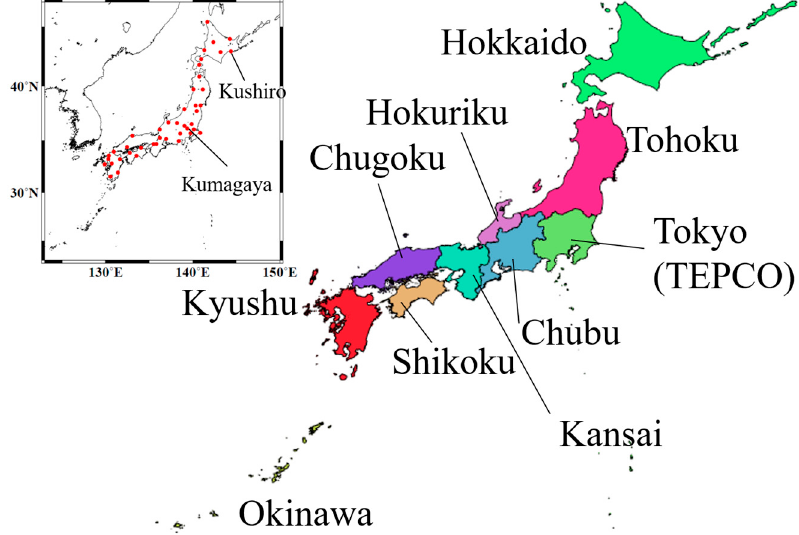
Figure 1. Map of Japanese islands and 10 electric power grids. Red squares indicate the locations of Japan Meteorological Agency’s (JMA’s) global horizontal irradiance (GHI) observation stations including the Kushiro and Kumagaya special GHI observation stations.